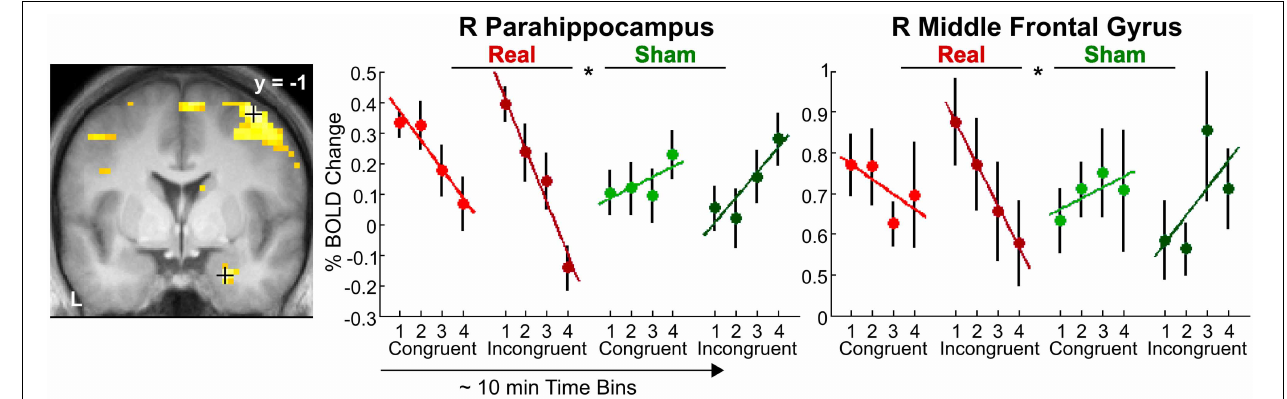
FIGURE 6 | Transient incongruency effects for crossmodal matching of haptic S2 (VH) evoked by rTMS conditioning. Regional activity in the right parahippocampus (MNI coordinates: x , y , z = 24 , − 1 , 29) and right middle frontal gyrus (39, − 1, 58) showed an interaction of linear time-dependent effects by rTMS condition that was stronger for incongruent than congruent trials: Whereas regional activity was initially increased and linearly decreased over time after real rTMS (red, real-congruent; dark red, real-incongruent), no significant linear